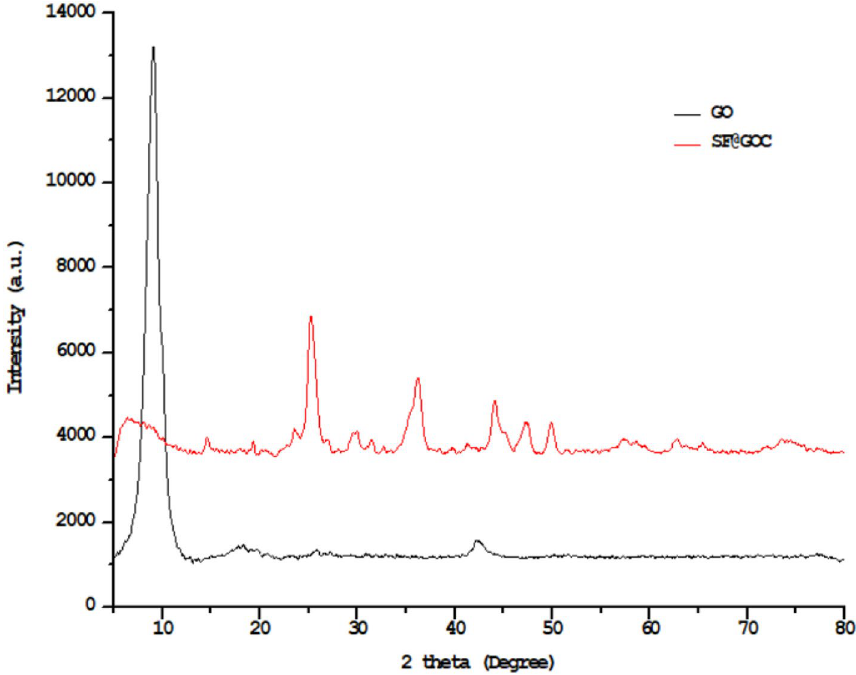
Figure 2. High angle powder XRD of GO and